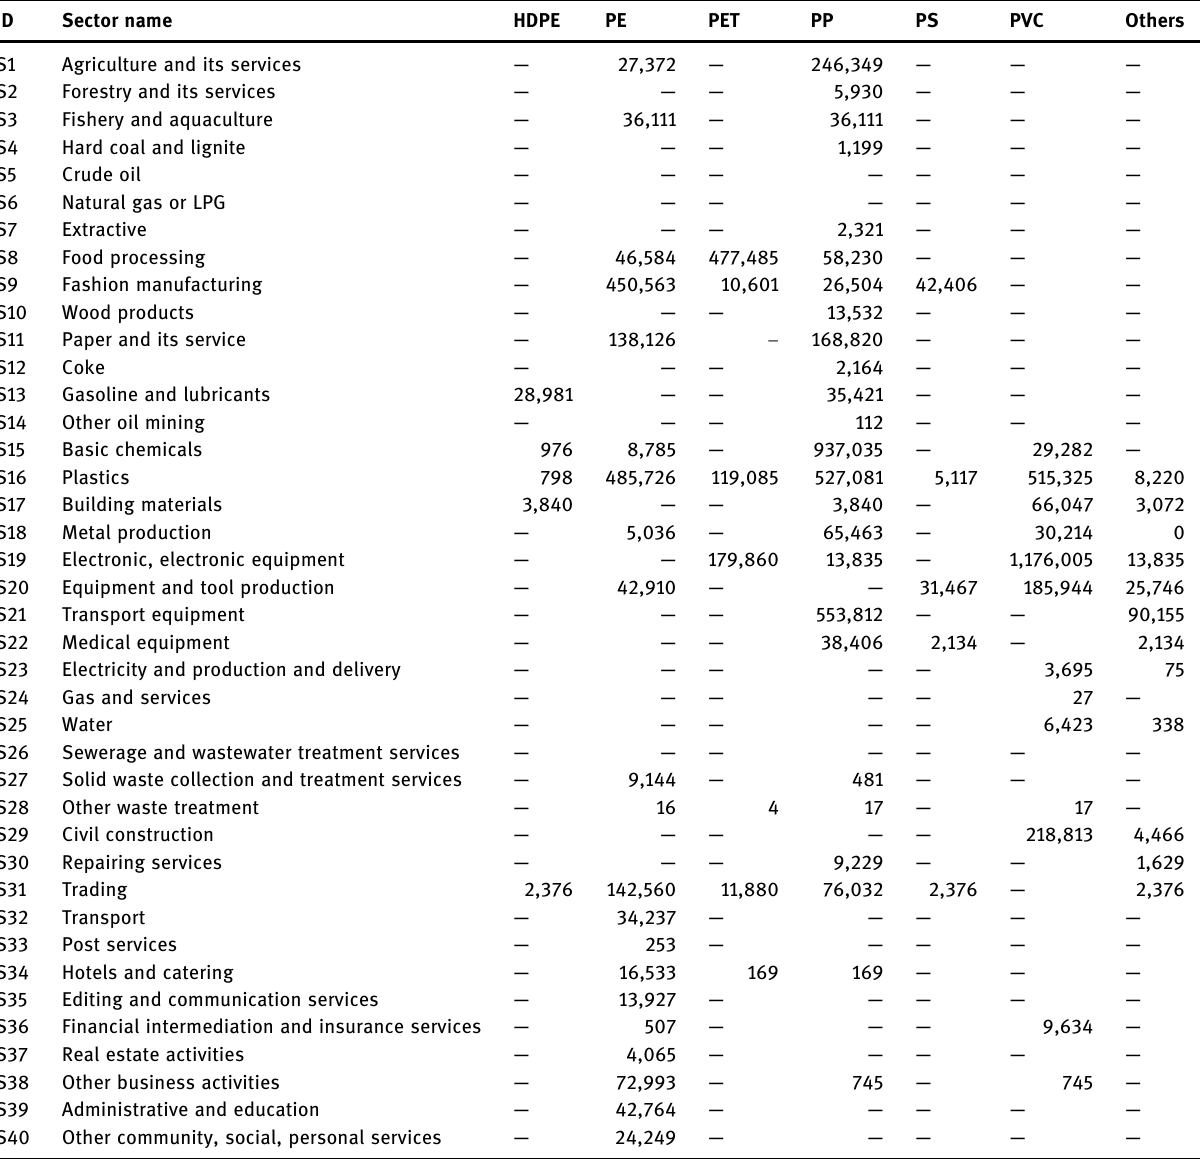
Table 1: Sectoral demand of di ff erent plastic types in